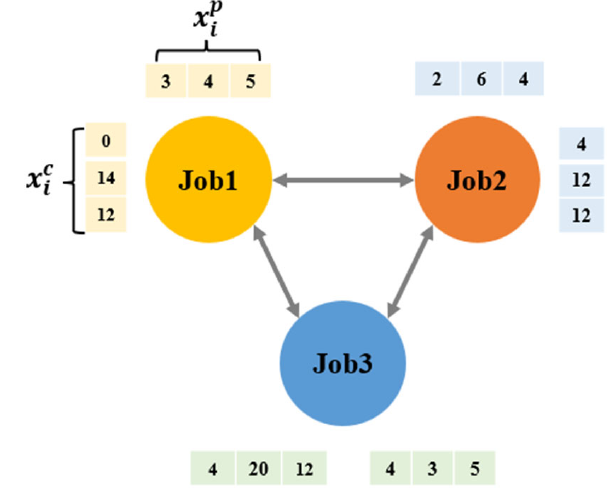
( l ) ∈ R d l is the graph-encoded vector of job i at the l -th layer with l ∈ { 1, . . . , L } , where x i the eigenvalues of the weight matrix ω ( l ) ∈ R d l − 1 × d l are regularized using a trainable variable γ ( l ) , Adj ( i ) denotes the set of all neighbouring nodes of node i , the information between the two layers is aggregated using the function ϕ ( l ) : R d l − 1 → R d l [37]. The second equation in Equation (8) represents the first layer of the GIN network, where each node inputs a feature vector (basic information about each job). The first equation indicates that in other layers of the network, each node updates its own features by aggregating them with those of its surrounding neighboring nodes, and the specific aggregation function and weight matrix are trainable. The aggregation function is implemented as a neural network, aggregating information from nodes in the lower layers of the GIN to the next layer. The deeper the layer of the network, the larger the range of neighbor nodes that will be aggregated. The mechanism for embedding aggregation of a node vector in GIN can be represented simply as Figure 6. The figure approximately shows the aggregation and update process of the GIN network when L = 2. The information of the one-order and two-order neighbors of job 1 will be aggregated. Each update of a node requires a combination of information about the node itself and information about its neighbors, and the aggregation function and the weights of the summation operation are parameters that can be